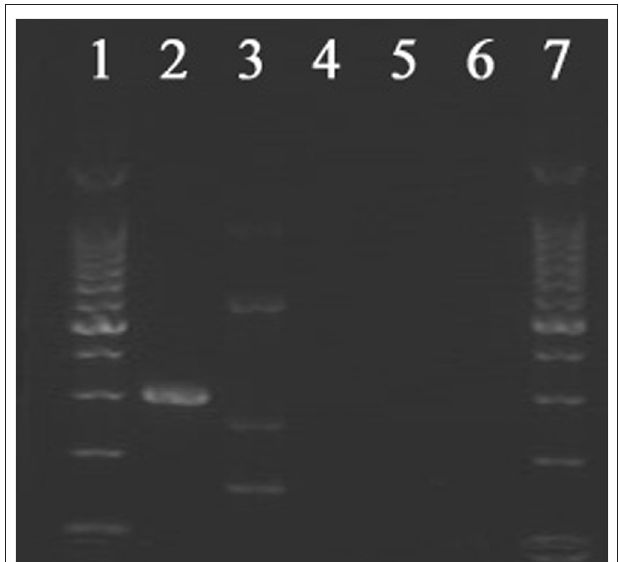
FIGURE 3 | Electrophoresis results of DNA isolated from partial of rectal swabs amplified with vanB primers. Lanes 1 and 7 contain 200 bp Marker. Lanes 2, 3, and 4 represent positive control, negative control, and blank control of vanB , respectively. Lanes 5 and 6 show electrophoretic results of DNA of Enterococcus isolated from different rectal swabs amplified by vanB primers. Electrophoresis results showed that these strains do not carry vanB .